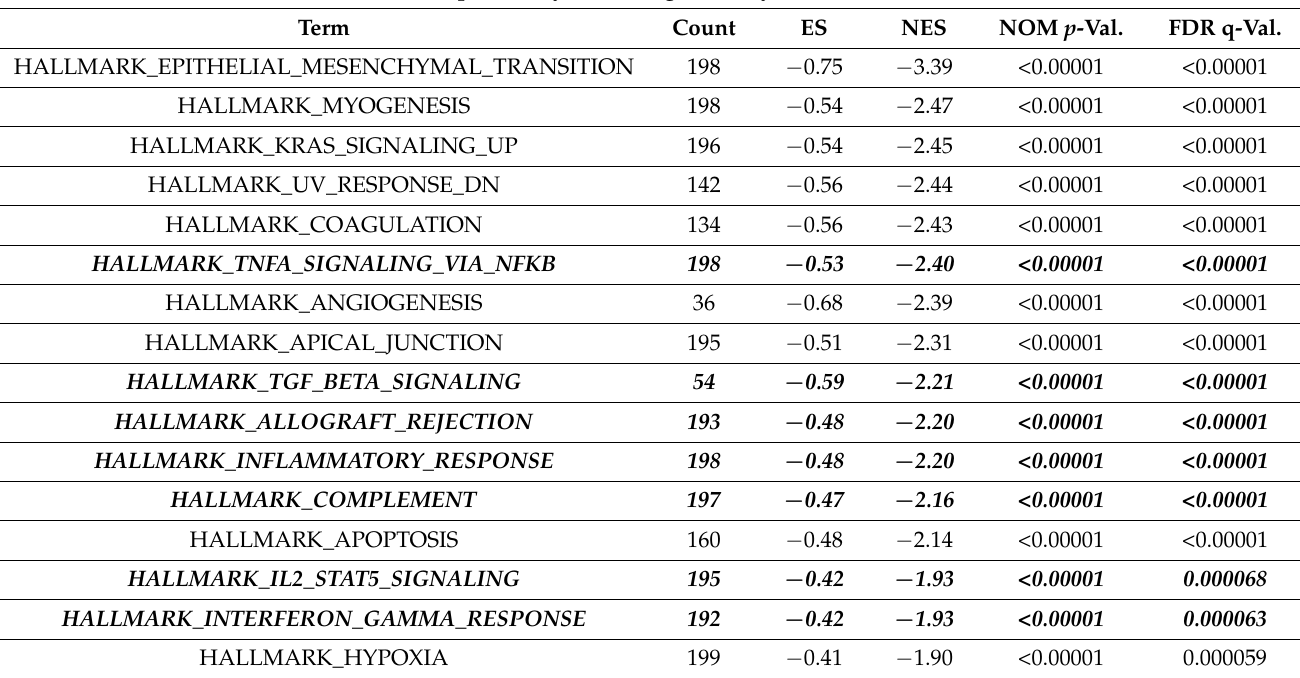
Term Count ES NES NOM p